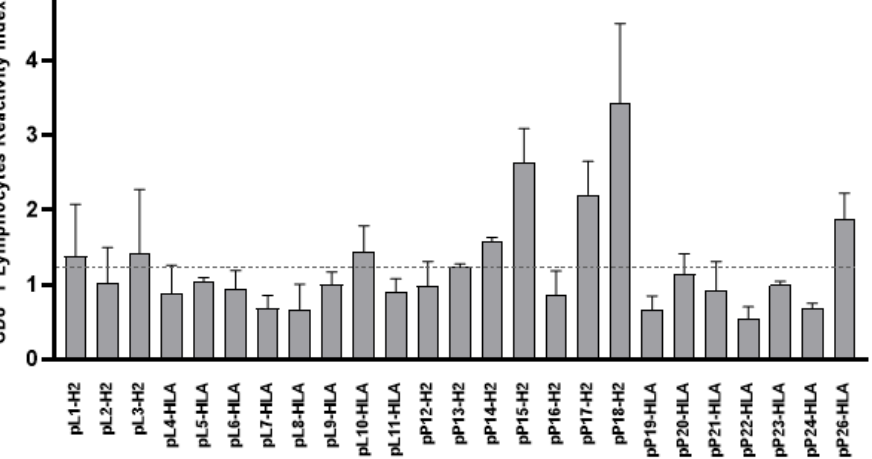
Figure 4. CD8+ T lymphocyte reactivity with DimerX. Assays were performed by flow cytometry and revealed the H2Db Ig/peptide complex. The experiments were conducted with a pool of cells from lymph nodes of L. amazonensis infected and non-infected mice. Each of the 25 peptides was coupled to DimerX-specific haplotype mouse cells. Cells were also marked with an anti-CD8 monoclonal antibody. The percentage of double-positive cells from infected mice was divided from the ratio found in cells from normal mice to determine the reactivity index shown in the figure. The horizontal line shows the 20% cutoff used to select peptides with greater specific interaction with infected lymphocytes.